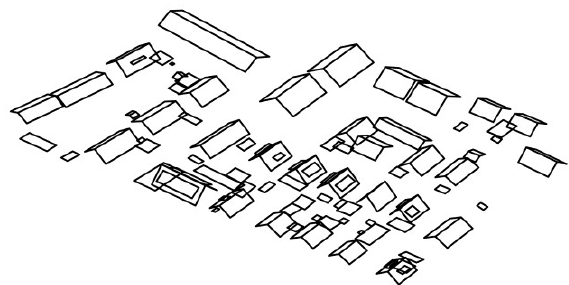
Figure 12. Reconstructed 3D building roofs of Area3.